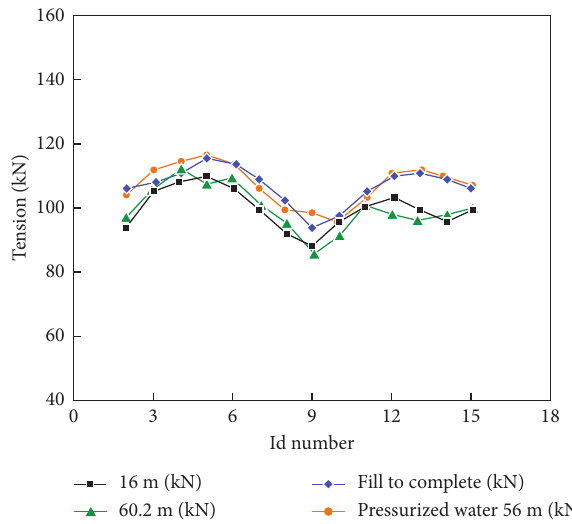
Figure 9: Test curve of the water pressure test process of the magnetic flux sensor after soil filling.